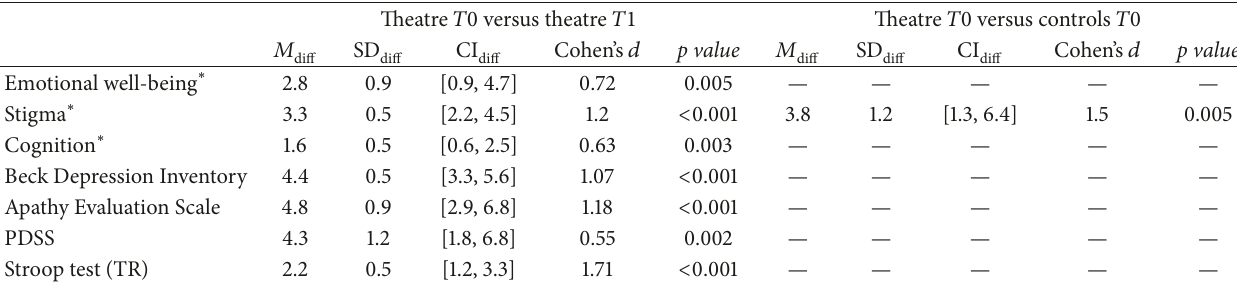
Table7: Posthocanalysesofsignificantinteractionsobtainedintwo-waymixed-designANOVAs[betweensubjects’factor: GROUP(theatre; controls); within subjects’ factor: TIME (𝑇0,𝑇1) , see Table 5 ] . Data are reported just for those post hoc tests which survived the Bonferroni correction. Asterisk ( ∗ ) indicates subscales of Parkinson’s Disease Quality of Life Scale. 𝑀 diff : differences between the means; SD diff : standard deviation of 𝑀 diff , CI diff : confidence interval of 𝑀 diff . Other abbreviations are as in Table 6. Theatre 𝑇0 versus theatre 𝑇1 Theatre 𝑇0 versus controls